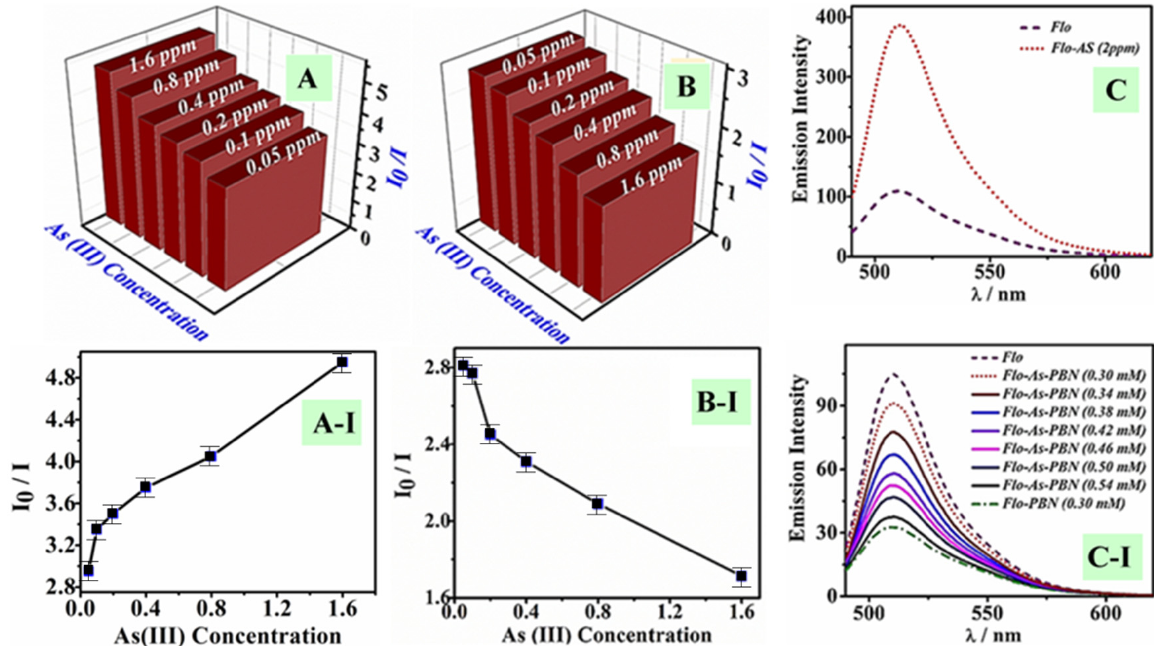
Figure 8. Bar diagram displaying fluorescence quenching (FQ) with respect to the variable concentration (effective concentration) of As(III) for the PBN@Flo-As(III) system ( A ) and the As(III)@PBN-Flo system ( B ). Plots of fluorescence intensity of the Flo-PBN system with respect to a variable content of As(III), showing concentration-dependent fluorescence quenching in both circumstances ( A-I , B-I ), with error bars representing the standard deviation. Emission spectra displaying the effect of adding 2 ppm of As(III) to the emission intensity of Flo ( C ). The required amount of PBN for complete quenching by adding various amounts of PBN to the Flo-As(III) system ( C-I ) and